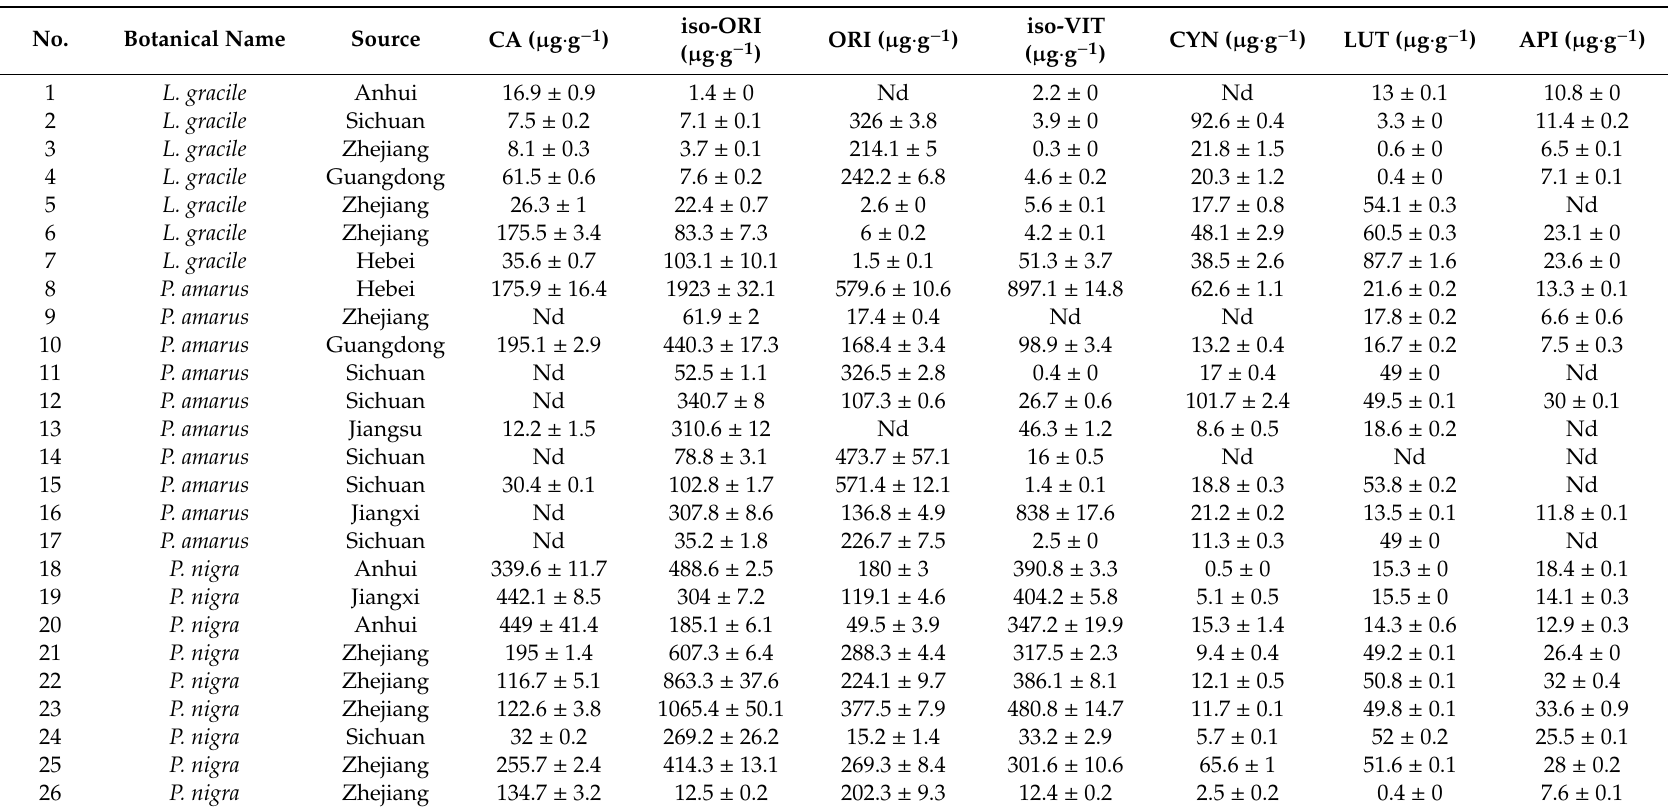
Table 3. The content results of the seven characteristic